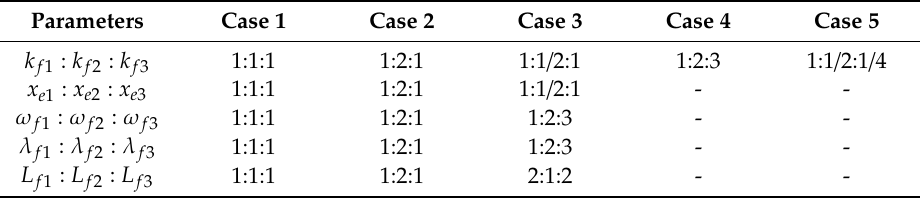
Table 3. The heterogeneous parameter ratio of three blocks.